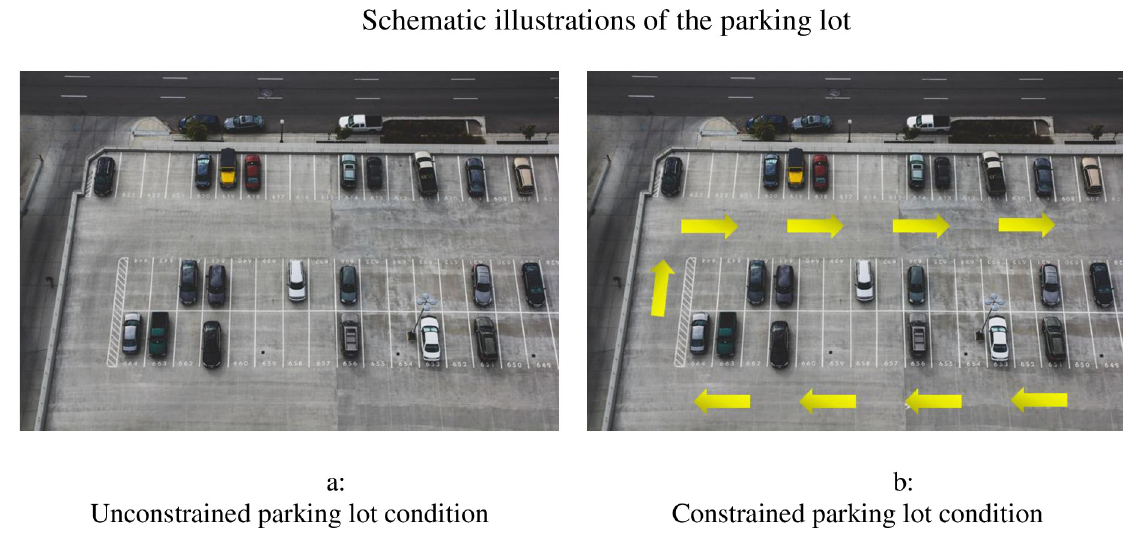
Fig 3. Schematic illustrations of the parking lot. a. Unconstrained parking lot condition. b. Constrained parking lot condition.